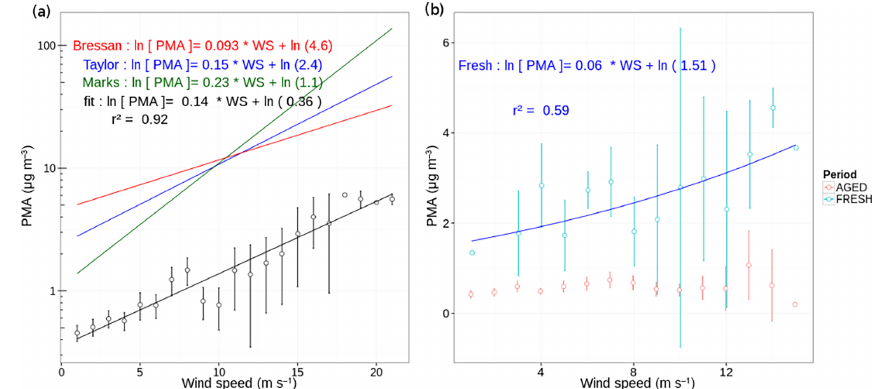
Figure 10. PMA concentration measured at Ersa as a function of wind speed for the ADRIMED period. The PMA concentrations have been √ N ( N is the number of independent measurements). (a) The black averaged by wind speed bins of 1ms − 1 . The error bars represent ± 2 σ / curve correspond to measurements, while the red, blue and green curves correspond to fits parameters by Bressan and Lepple (1985); Taylor and Wu (1992); Marks (1990). Panel (b) represents fresh (blue curve) and aged (red curve) PMA over the whole